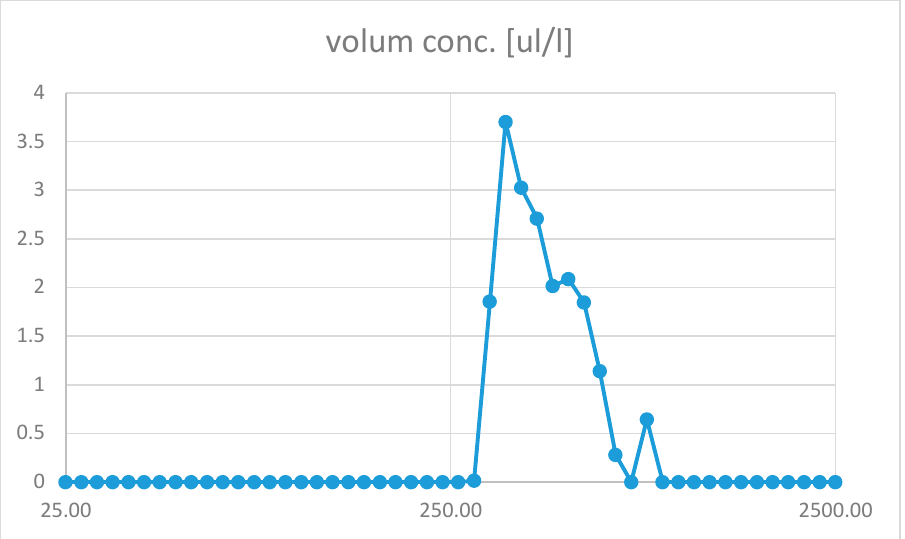
Figure 8. MP size distribution measured in Goro.